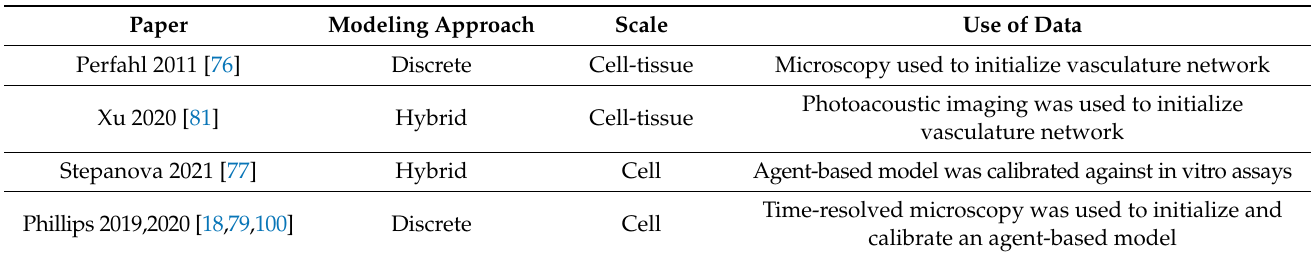
Table 2. Examples of studies integrating imaging data with mathematical modeling at the cell scale.